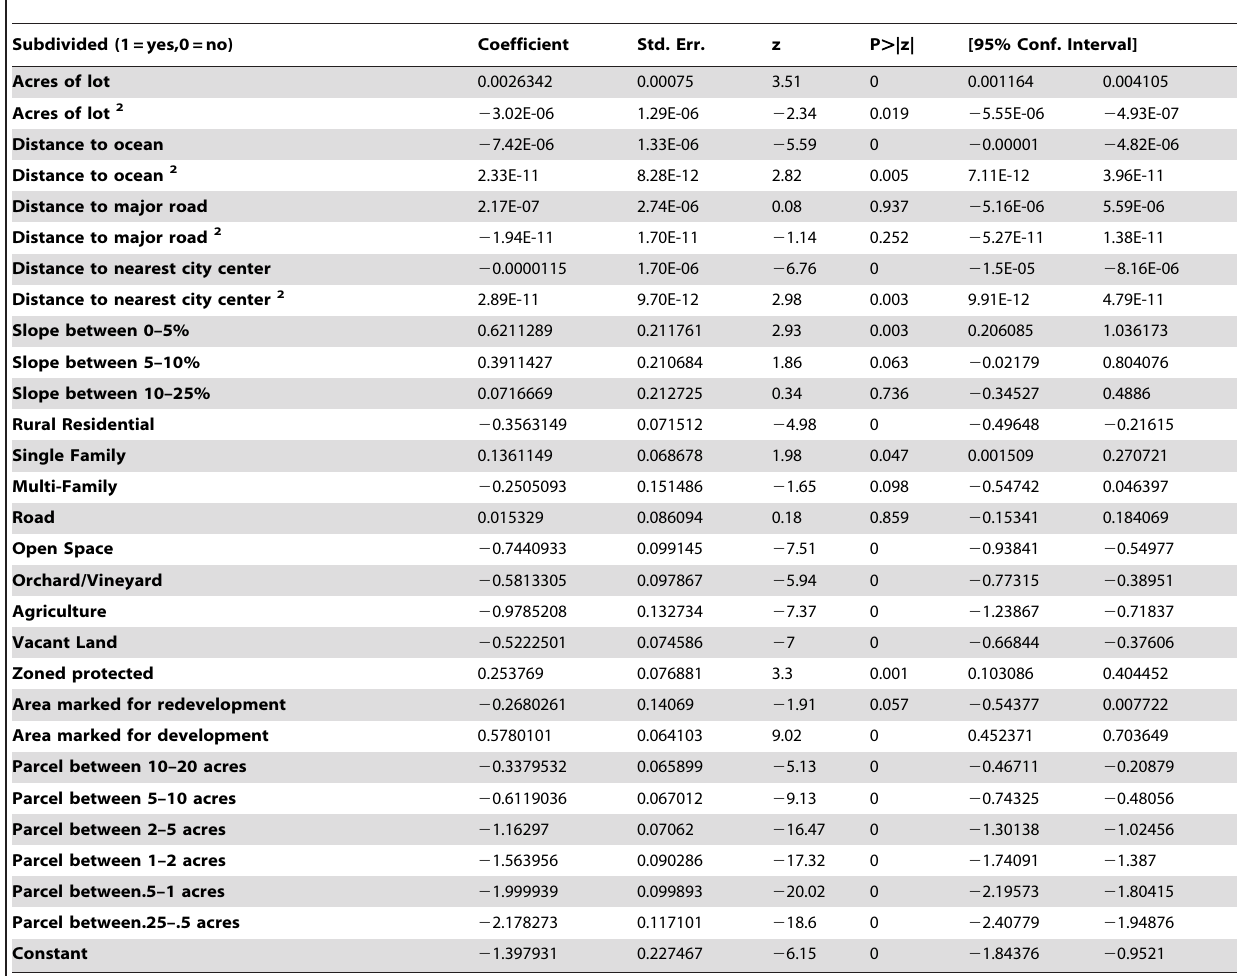
Table 1. Variables and results from the probit regression model of parcel subdivision in San Diego County.